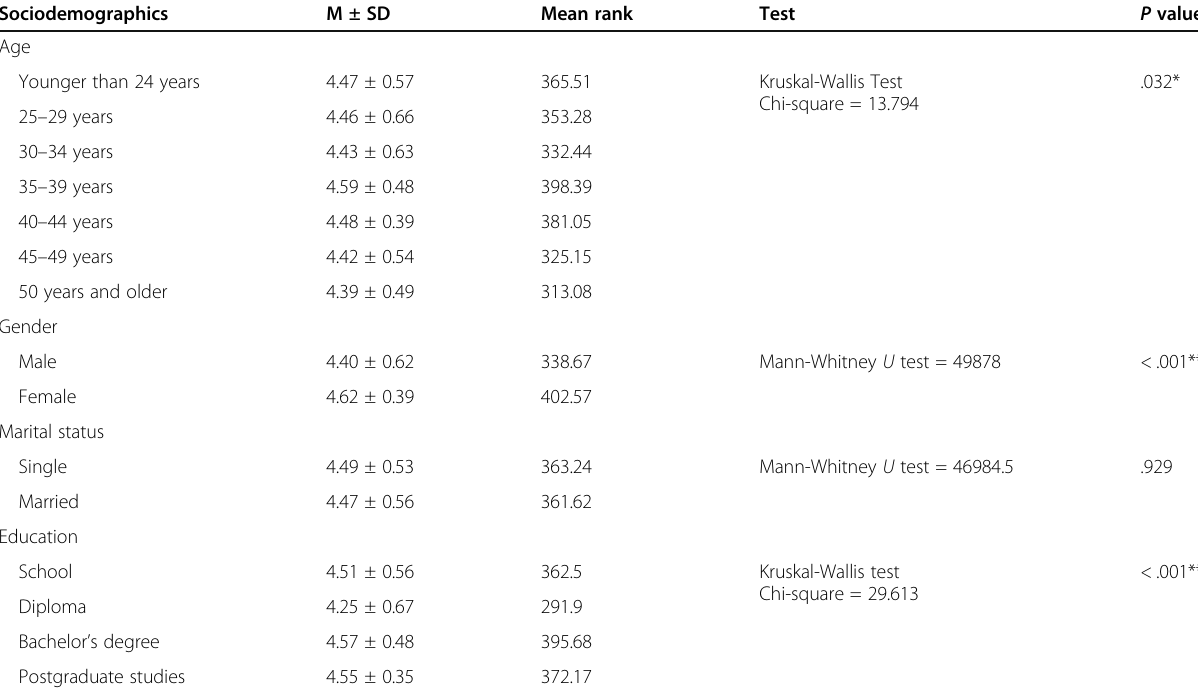
Table 12 Differences in mean self-efficacy total scores, according to sociodemographic characteristics